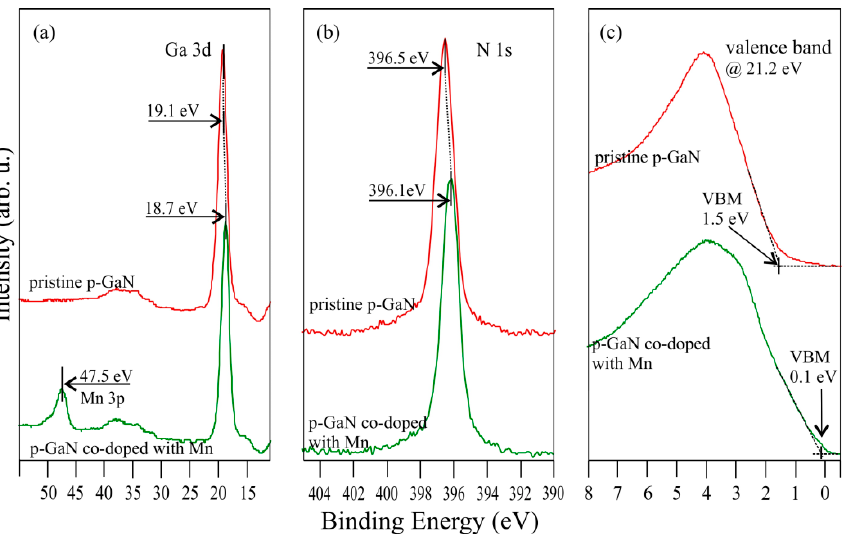
Figure 17. XPS spectra of ( a ) Ga-3d with Mn-3p, ( b ) N-1s, and ( c ) valence band for a pristine p - GaN(0001) substrate, codoped with Mn by thermal annealing of Mn/GaN system. Data previously published in [24].